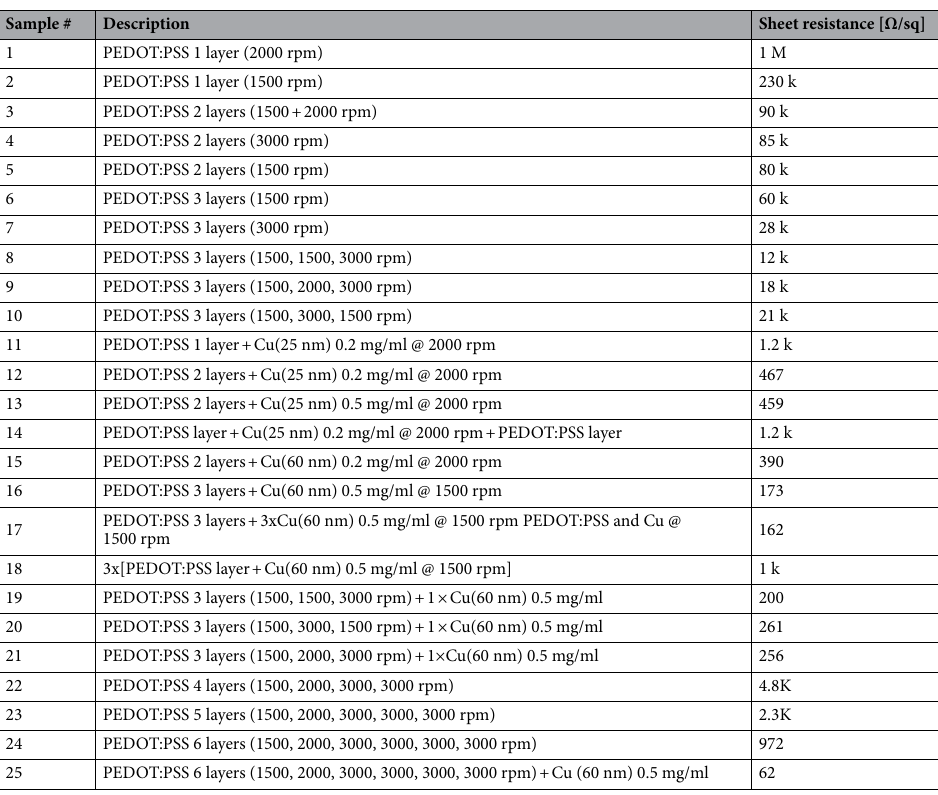
Table 1. Samples with various processing steps and the resulting sheet resistance. The process steps to enhance electrical conductivity are discussed in the text.